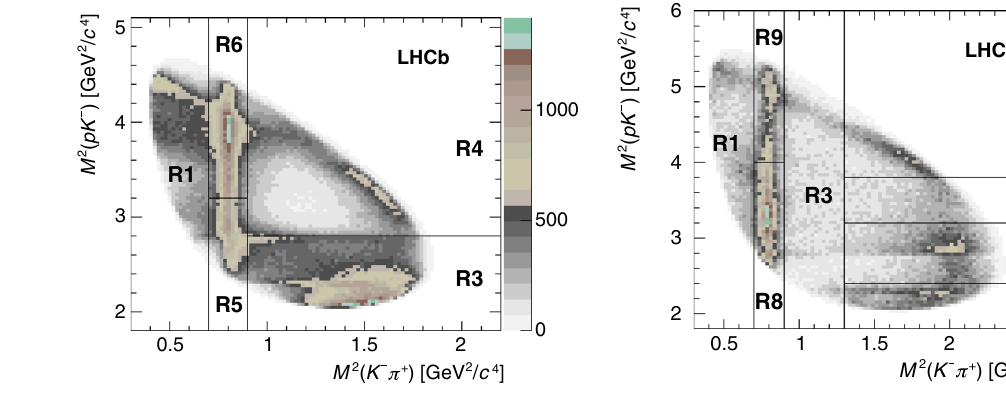
The presented distributions correspond to the 2012 data sample